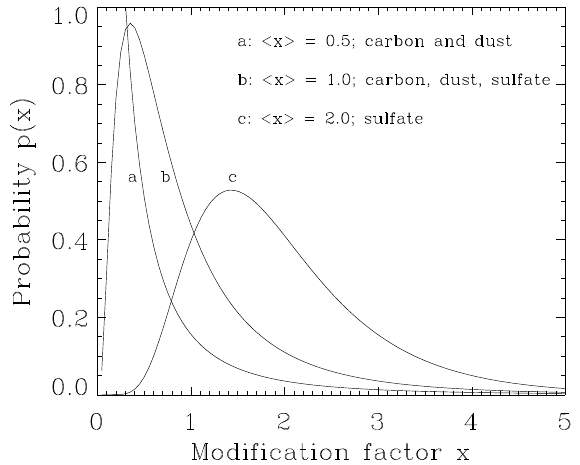
Fig. 24. The lognormal distributions that yield the random factors to modify SPRINTARS standard emission scenarios. In all cases the standard deviation is 1. Distributions (a) and (c) are used in this paper. In paper I, (b) was also used.